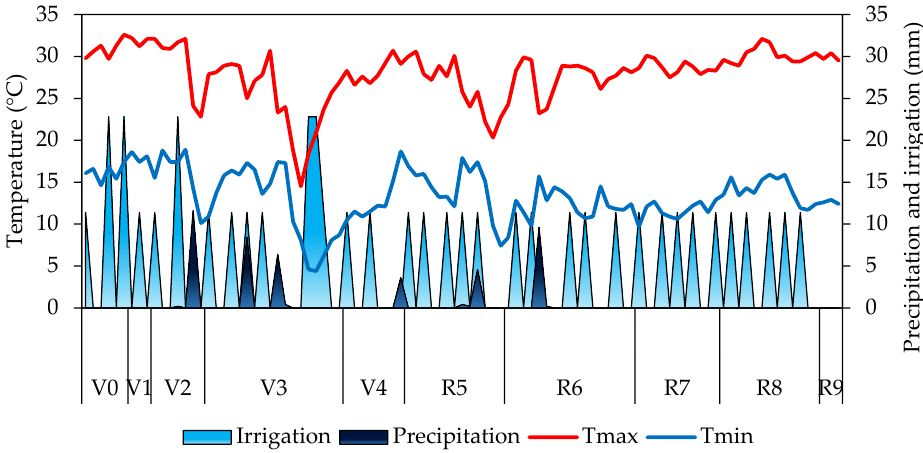
Figure 1. Climatic conditions during the common bean growing stages (from V0 to R9).